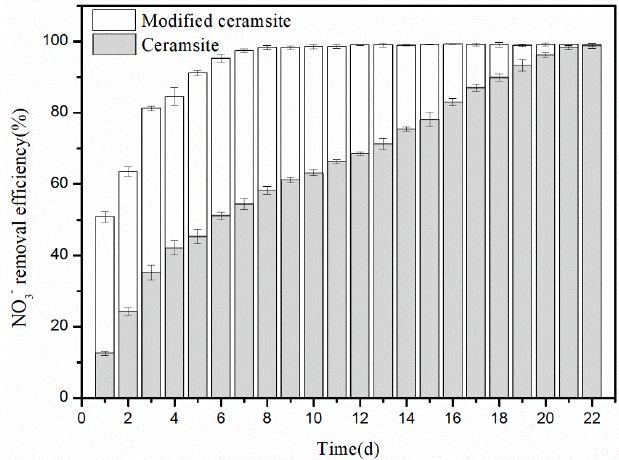
Figure 6. NO 3 − removal efficiencies for modified ceramsite and commercial ceramsite as fillers in the biotrickling filter during the start-up period.